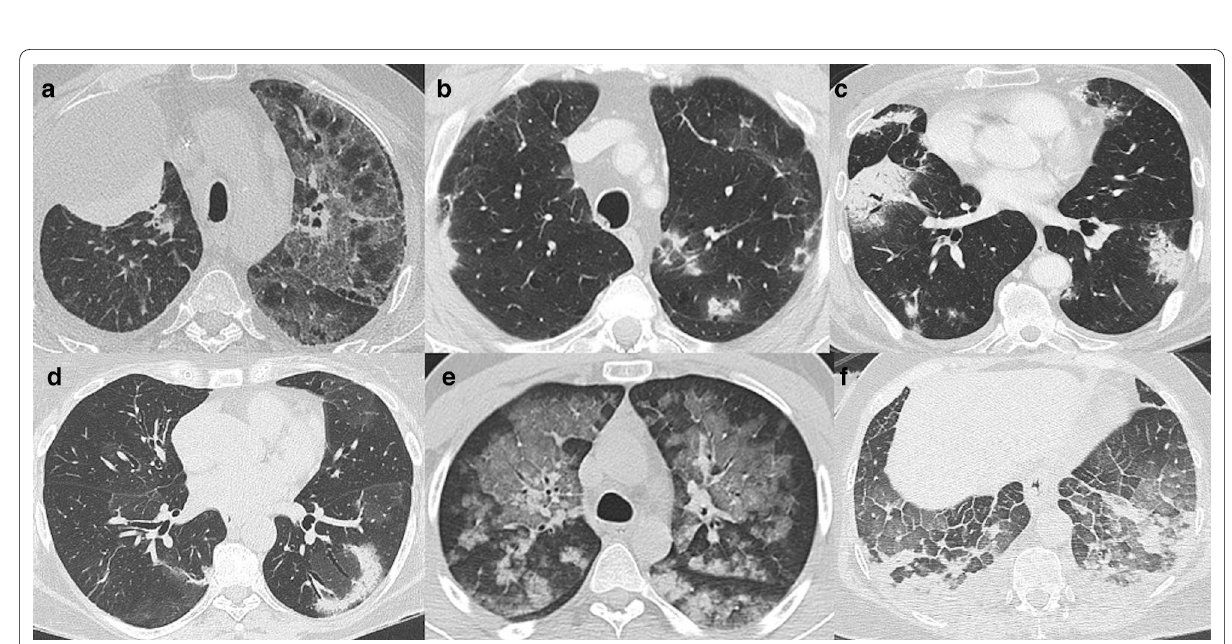
Fig. 12 Axial CT images of different cases of ChT/RT-related lung toxicity. a shows acute pneumonitis after the first administration of an anti-PD-1 target immunotherapic agent (Pembrolizumab) in a patient with right lung cancer. Also Nivolumab (another anti-PD-1 agent) can cause lung adverse disease with interstitial pneumonitis presenting with organizing pneumonia pattern, as shown in ( b , c ). An example of radiation-primed cryptogenic organizing pneumonia is reported in ( d) , which shows the so-called “reverse halo sign” or “atoll sign” in the left lower lobe after RT for breast cancer. e Shows acute and diffuse alveolar hemorrhage in a patient with NSCLC treated with Bevacizumab, with bilateral GGOs caused by blood filling alveolar spaces. Acute lung edema with bilateral smooth lobular septal thickening and GGOs in a patient treated with IL-2 is shown